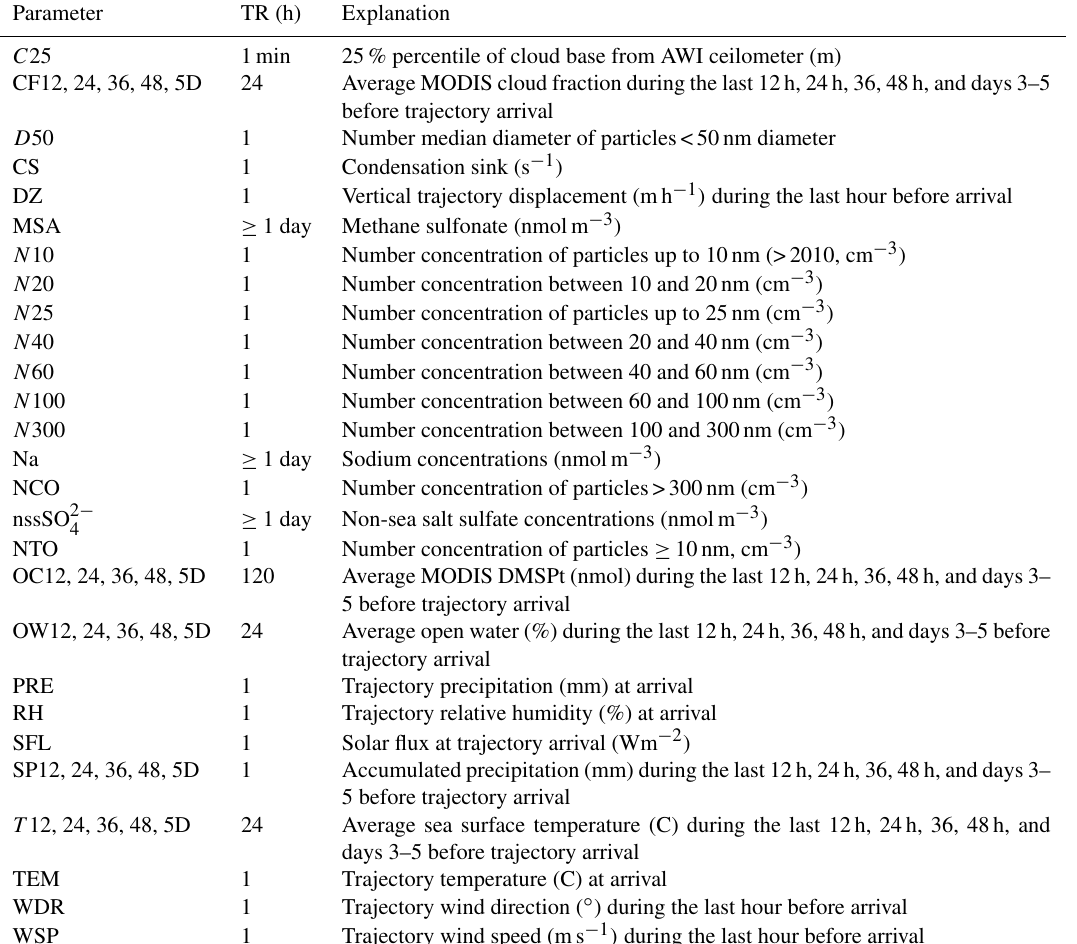
Table 1. Aerosol, atmospheric, and ocean parameters utilized in the present study. DMSPt is total dimethylsulfoniopropionate in surface ocean waters. TR is temporal resolution in which the respective data were available. All parameter explanations starting with “Trajectory” refer to parameters calculated by HYSPLIT4 at each trajectory